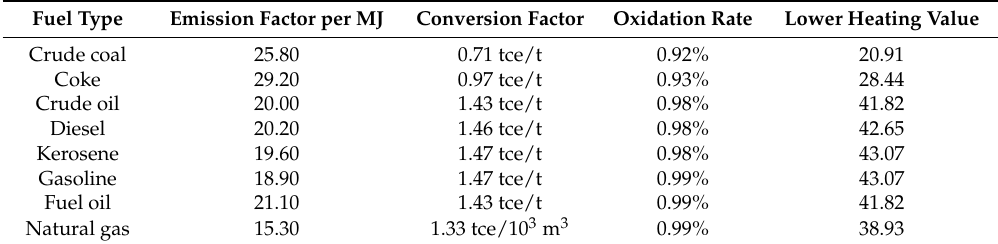
Table 4. Energy consumption carbon emission conversion